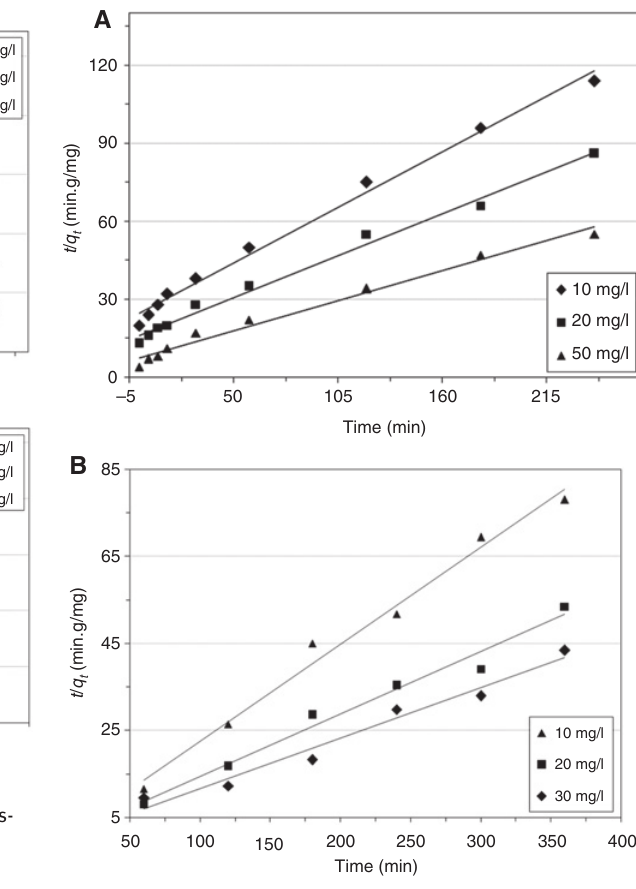
Figure 7: Pseudo-second-order plots for Mn-doped